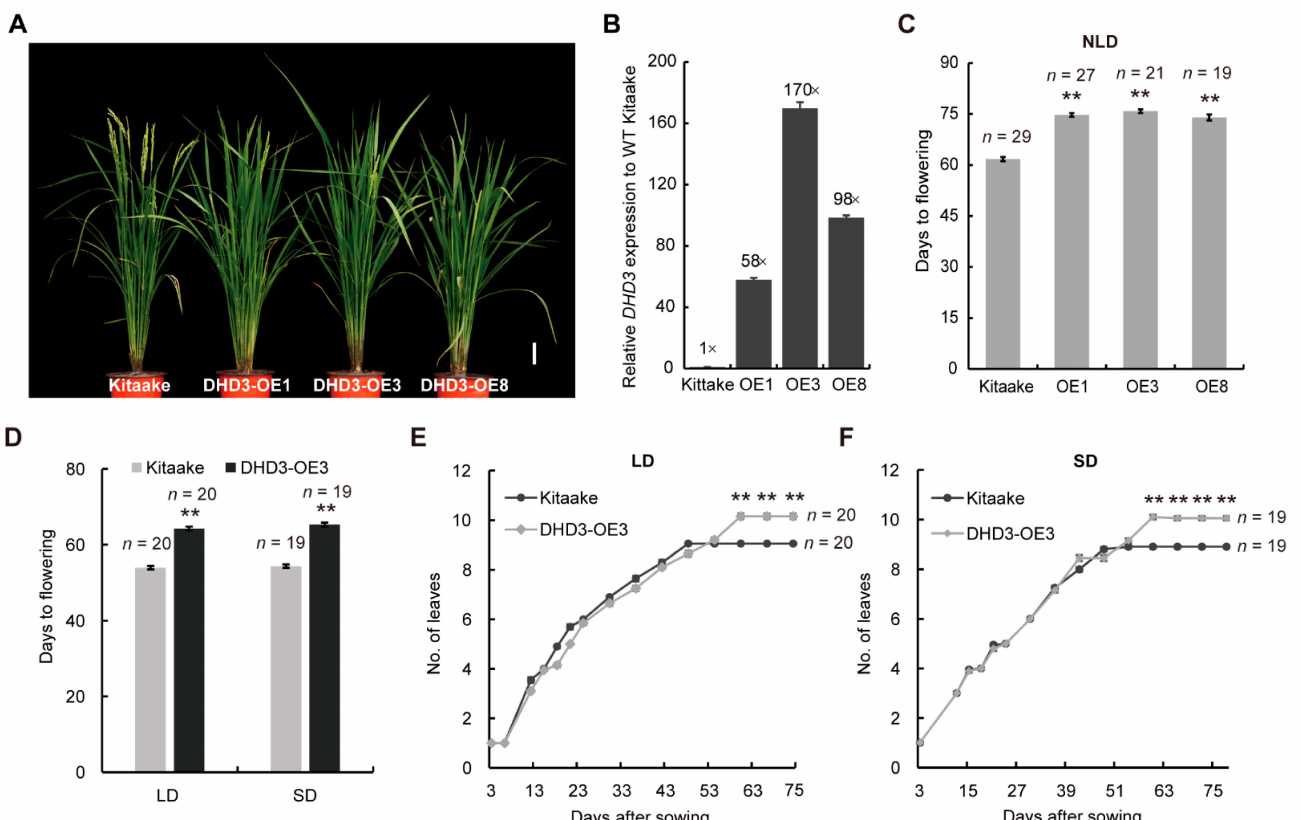
Figure 1. Phenotypic characterization of DHD3 overexpressed (OE) plants. ( A ) WT and DHD3 overexpressed plants that grew in a paddy field under the natural long-day (NLD) condition for 70 days. Scale bars, 5 cm. DHD3–OE1, DHD3–OE3, and DHD3–OE8, independent overexpressed lines of DHD3 . ( B ) Expression levels in overexpressed plant lines. The labeled numbers are fold change of expression level relative to wild type (WT) Kitaake. ( C ) Heading dates of WT and DHD3 overexpressed plants under the NLD condition. Means ± s.e. ( n > 15). ( D ) Heading dates of WT and DHD3–OE3 overexpressed plants under control LD (long-day) and SD (short-day) conditions. Means ± s.e. ( n > 15). ( E , F ) Leaf emergence rate of WT and DHD3–OE3 overexpressed plants under LD and SD conditions. Means ± s.e. ( n > 15). LSD -test, ** p ≤